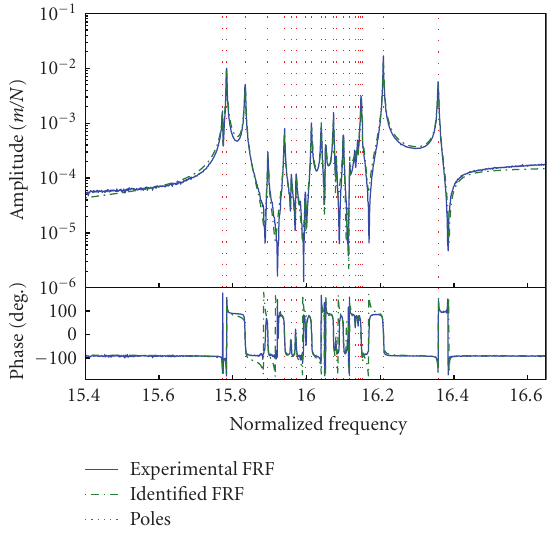
Figure 7: Modal identification.